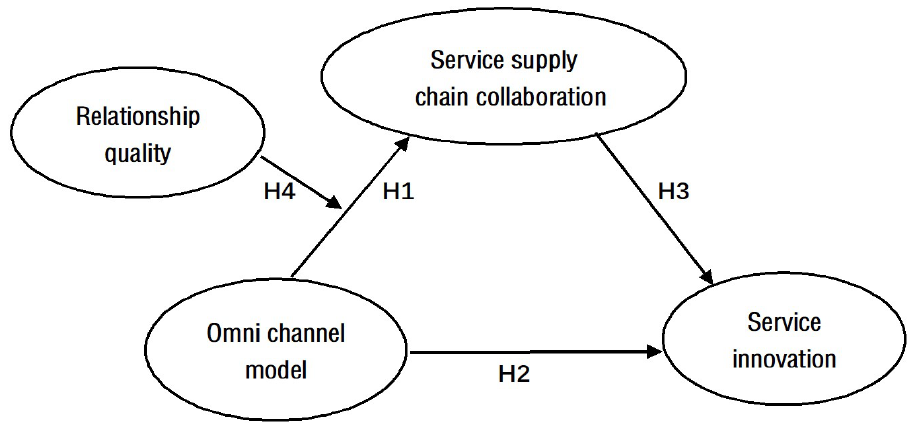
Figure 1. OC model, SSC collaboration and service innovation model.